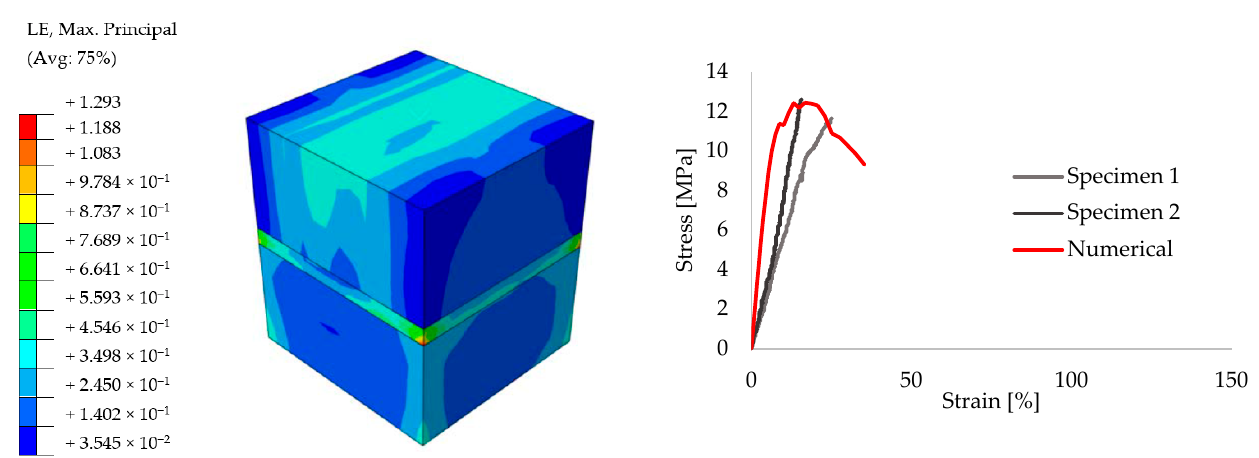
Figure 10. Compression results for the small size specimens with mortar: true strain diagram ( left ) and comparison of the